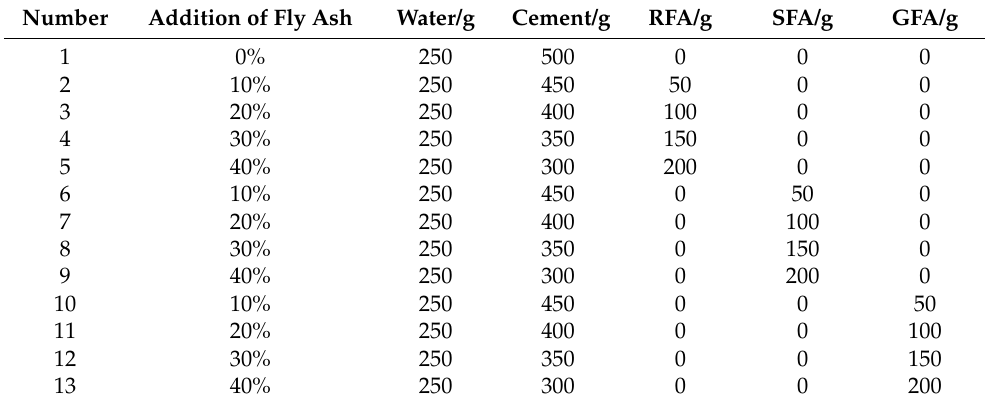
Table 2. Mix proportioning of cement paste containing fly ash.